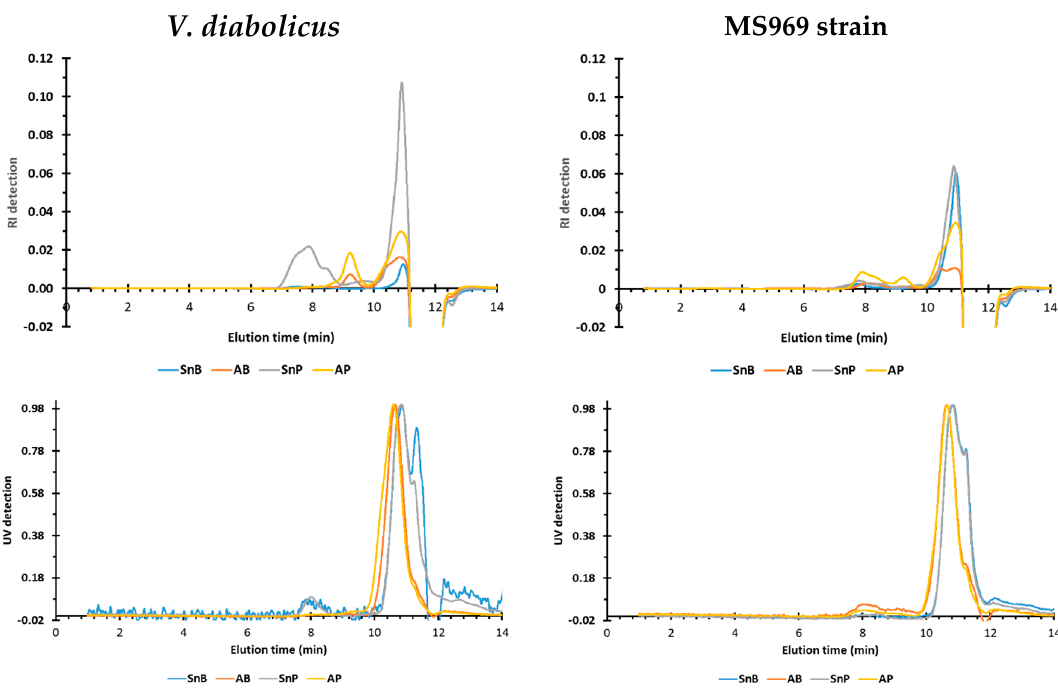
Figure 8. RI (refractive index) and UV profiles on the HPSEC column of V. diabolicus and MS969 extracts.